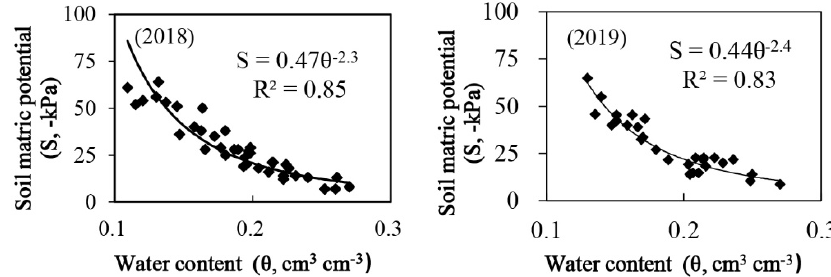
Figure 1. The soil water retention characteristics of experimental fields in 2018 and 2019.